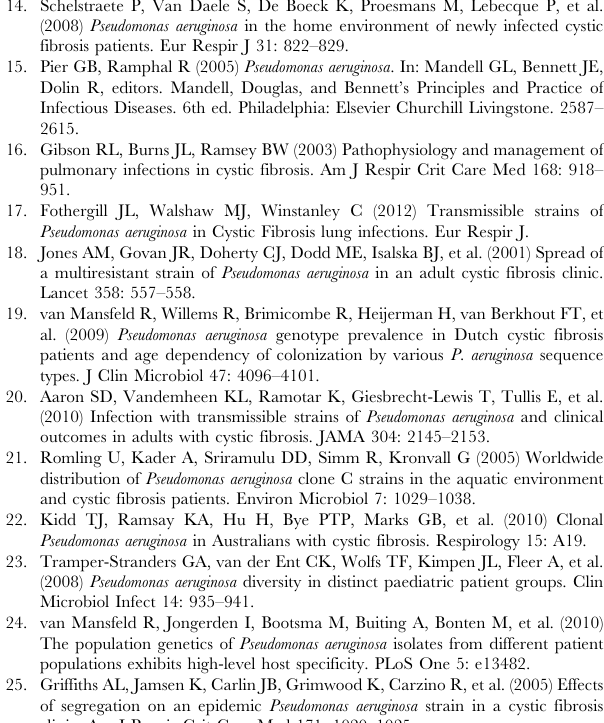
Figure S1 Map (1:272,536) of the Logan River showing land use categories. Figure S2 Map (1:136,268) of the North Pine River showing land use categories. Figure S3 Results of eBURST analysis for the 499 Pseudomonas aeruginosa isolates. Total no. of isolates = 499; Total no. of ST =272; No. of loci per isolate = 7; No. of identical loci for group definition =6; Total no. of BURST groups detected = 31; No. of re-samplings for bootstrapping = 1000. Figure S4 Results of eBURST analysis for the 1070 Pseudomonas aeruginosa sequence types listed in the Pseudomonas aeruginosa PubMLST database. P. aeruginosa